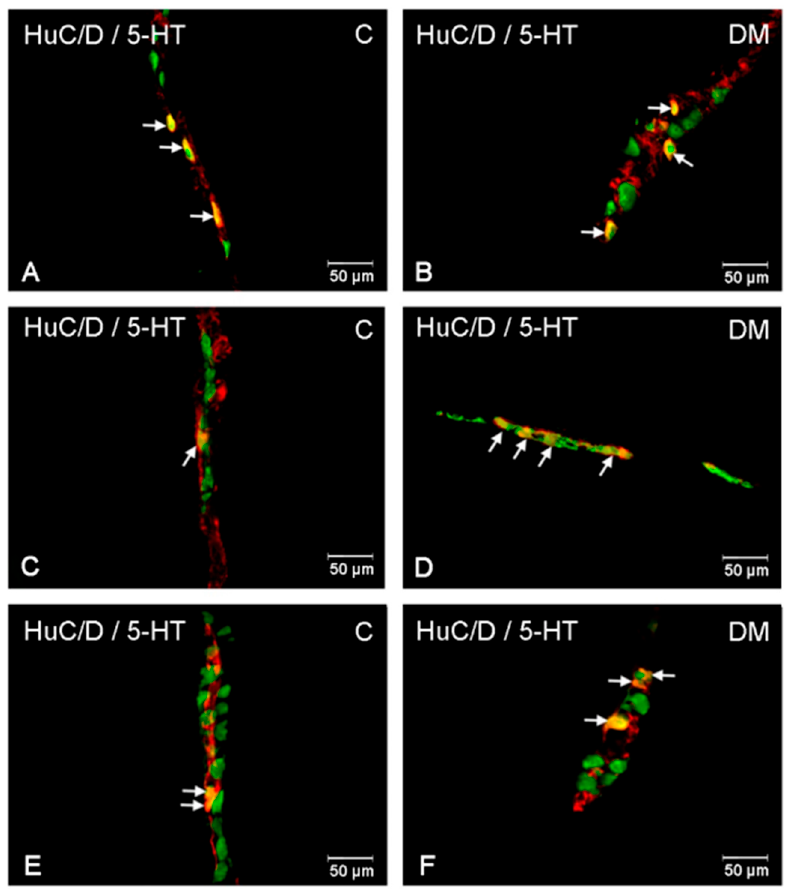
Figure 8. Immunofluorescent microphotographs showing serotonin immunoreactive perikarya in ileum in the myenteric plexus of the control ( A ) and in experimental group ( B ); inner submucosal plexus of the control ( C ) and in experimental group ( D ); outer submucosal plexus of the control ( E ) and in the experimental group ( F ). (C)—control group; (DM)—diabetes m mellitus. Photographs in the right column were created by digital superimposition of two-color channels; Hu C/D- (green) and serotonin-positive (red). The arrows indicated studied cells’